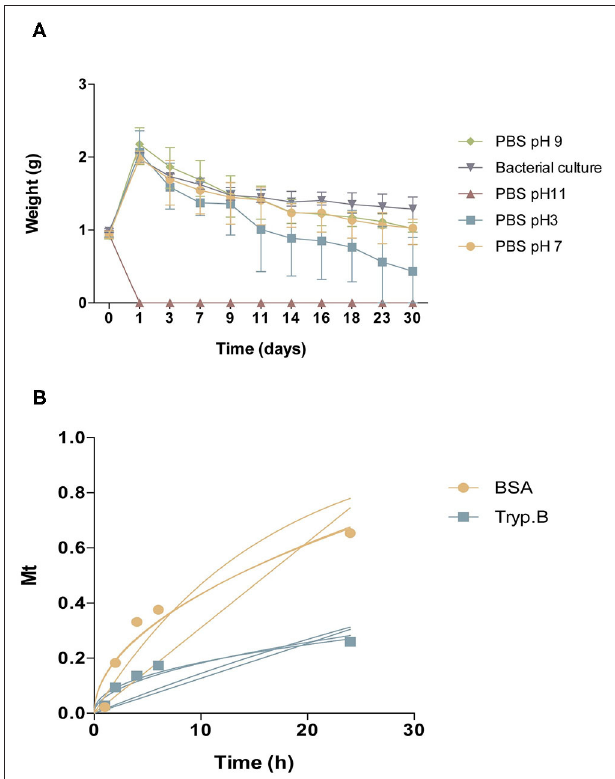
FIGURE 2 | Characterization of CoverGel. (A) Degradation of the hydrogel when placed for 30 days under different conditions ( PBS pH3, PBS pH7, PBS pH9, PBS pH 11, and bacterial culture). Graph represents weight of hydrogel over days. (B) Drug-release kinetics for Bovine serum albumin and Trypan blue. Graph represents concentration of substance on release medium (Mt) over time. Lines represent the different mathematical models tested.